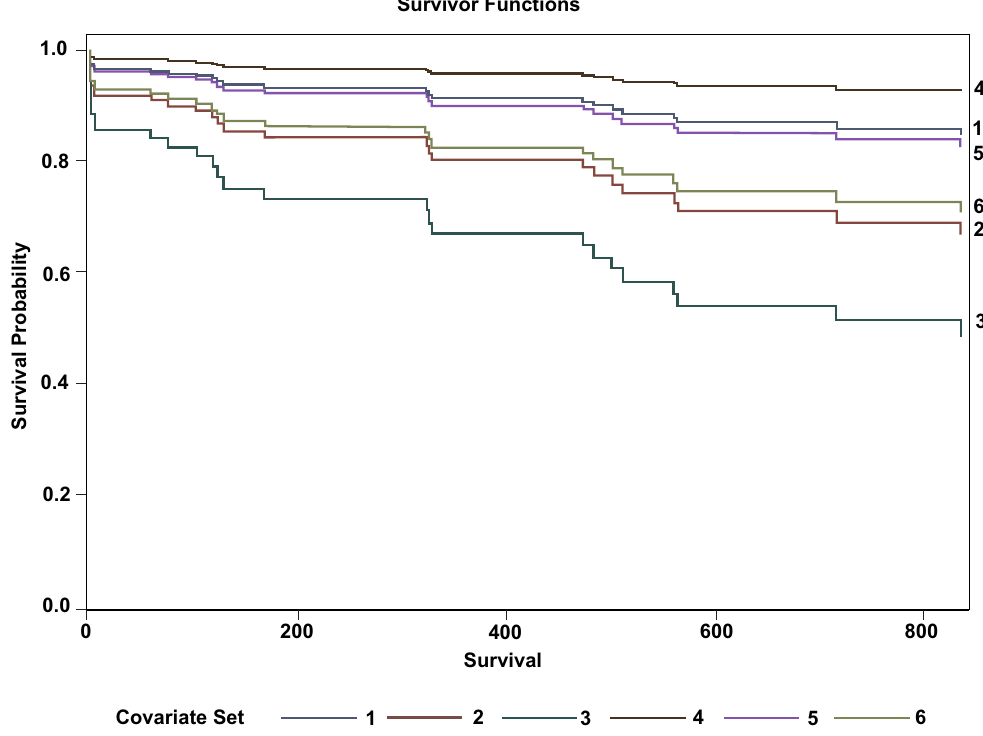
Figure 15. Estimated survival (days) curves for patients with PC from colorectal origin. 1: males, 37°C; 2: males, 40°C; 3: males, 42°C; 4: females, 37°C; 5: females, 40°C; 6: females, 42°C. All at 579 minutes operation time (mean) and 9.9 lactate mmol/l (mean).